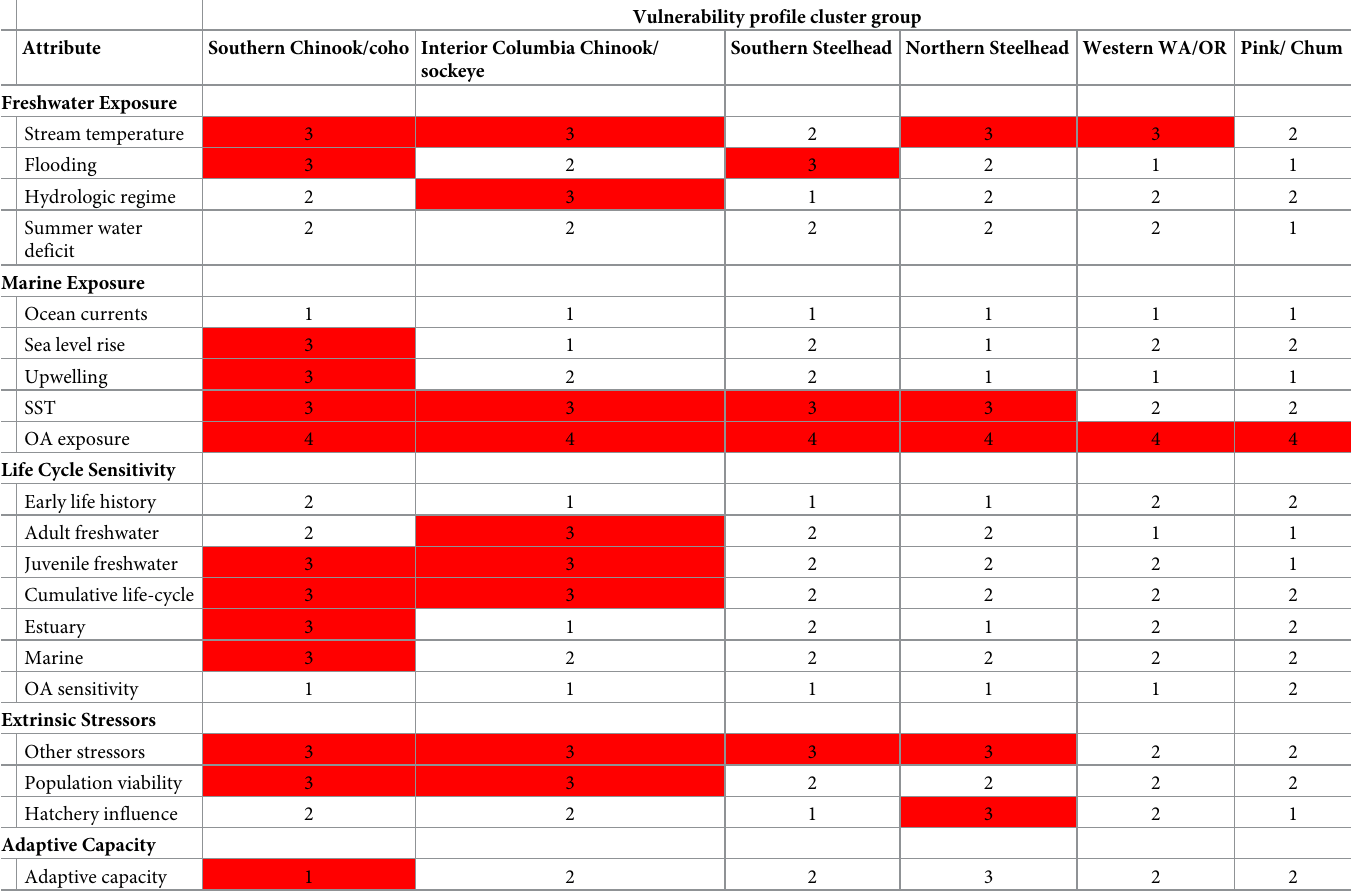
Table 4. Vulnerability profiles by cluster. Mean cluster score was the mean attribute score across DPSs within the cluster. Scores were rounded down for each attribute. Red cells indicate a mean score of 3 or higher for exposure and sensitivity or lower than 1.5 for adaptive